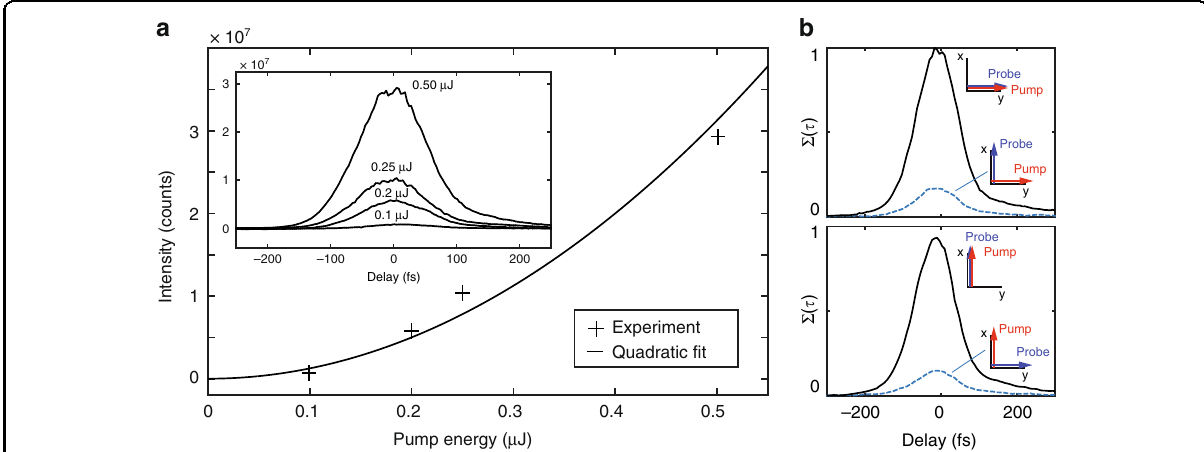
Fig. 2 Cross-correlation signal. a Peak cross-correlation signal as a function of pump intensity. Crosses show experimental data and a quadratic fi t is shown as solid line. (inset) Cross-correlation signal as a function of pump – probe delay for different pump intensities, showing the peak position and shape are invariant with pump power. b Cross-correlation signal as a function of pump – probe delay for the four combinations of pump and probe polarization orientations. The parameters are provided in the “ Methods ”